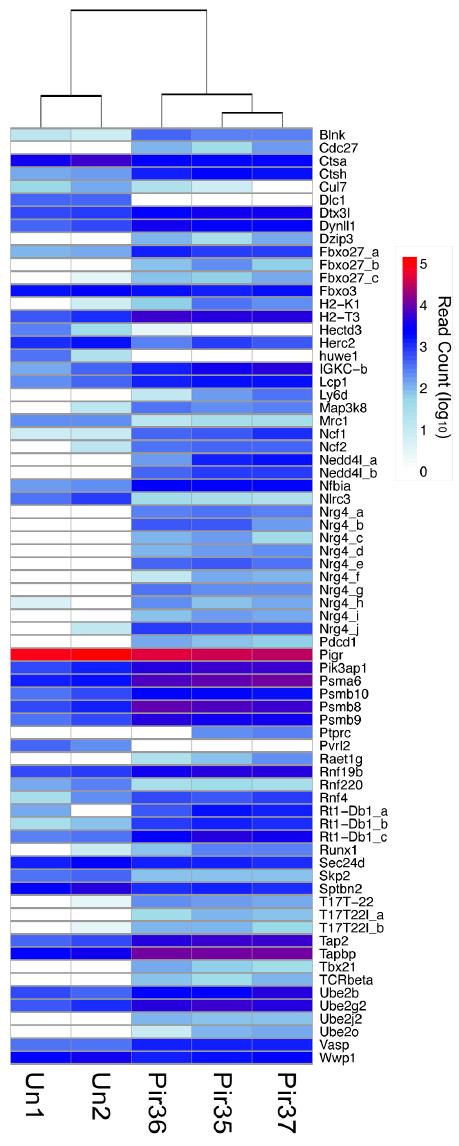
Figure 7. Differential expression of adaptive immunity transcripts. Differential expression (DESeq) data was plotted by cluster analysis with R software (pheatmap). Infected (Pir35, Pir36, Pir37) and uninfected (Un1, Un2) hamster livers, as described in Figure 6.